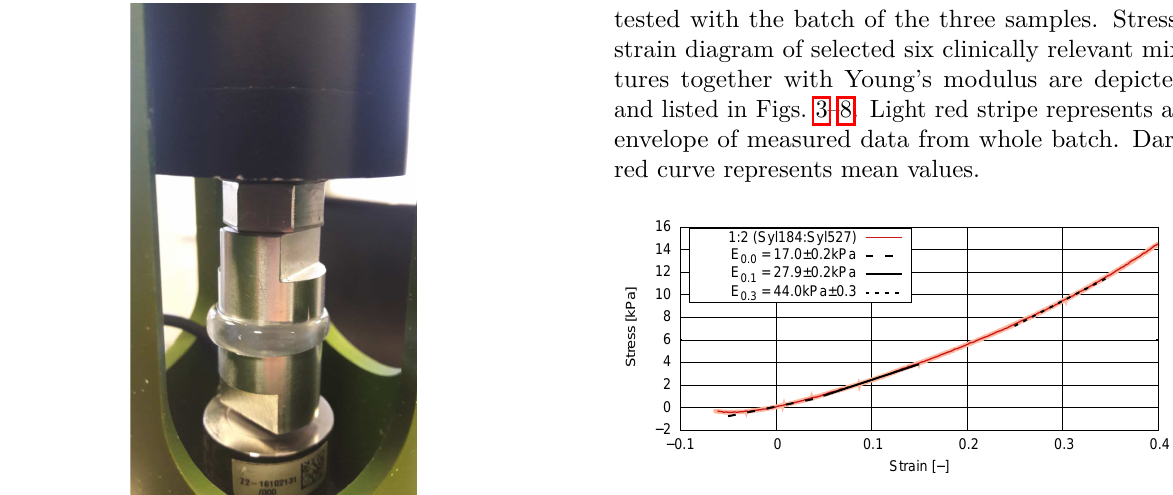
Figure 3. Deformation behaviour of 1 to 2 (Syl- gard 184 to Sylgard 527) mixture